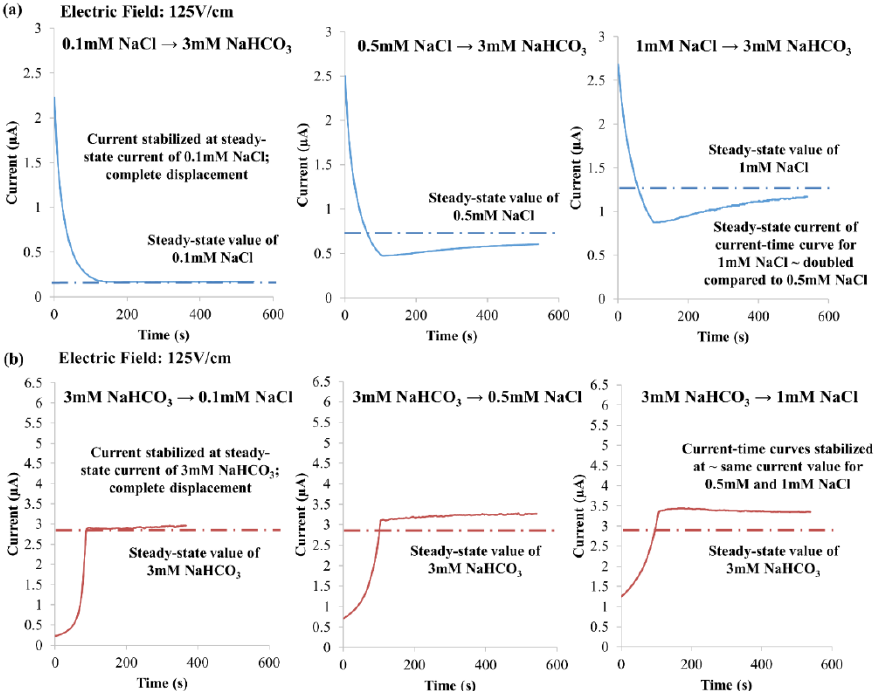
Figure 11. Experimental observations of varying NaCl concentration, i.e., 0.1 mM, 0.5 mM and 1 mM, with the NaHCO 3 concentration fixed at 3 mM and an electric field of 125 V · cm − 1 . ( a ) NaCl → NaHCO 3 (arrow indicates EOF direction), and ( b ) NaHCO 3 → NaCl.